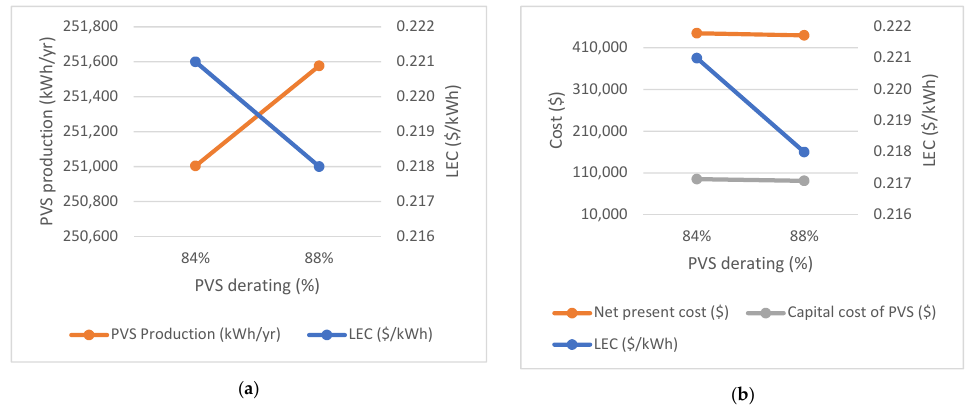
Figure 20. Effect of rising PVS derating ( a ) Effect of 84% and 88% PVS derating for PVS production and levelized energy cost (LEC); ( b ) effect of 84% and 88% PVS derating for capital cost of PVS, net present cost and levelized energy cost (LEC).